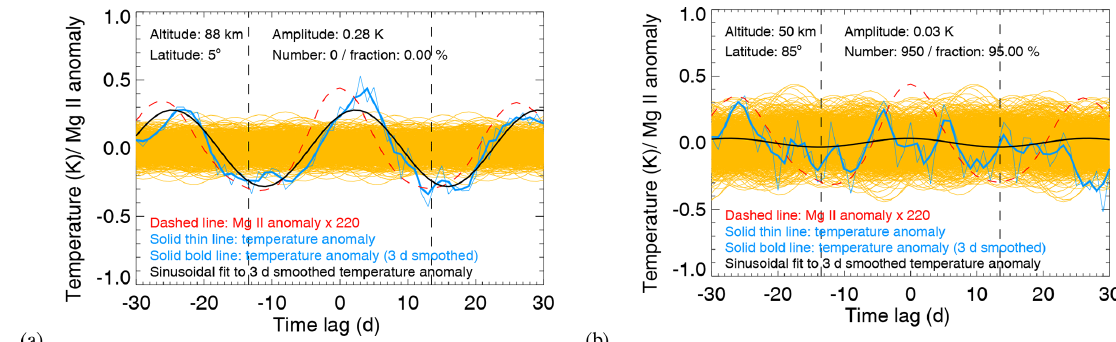
Figure 10. Similar to Fig. 7a except that the orange lines are a sinusoidal fit to the 3d smoothed epoch-averaged temperature anomalies for 1000 randomly chosen epoch ensembles. (a) For an altitude of 88km and a latitude of 5 ◦ N. (b) For an altitude of 50km and a latitude of 85 ◦